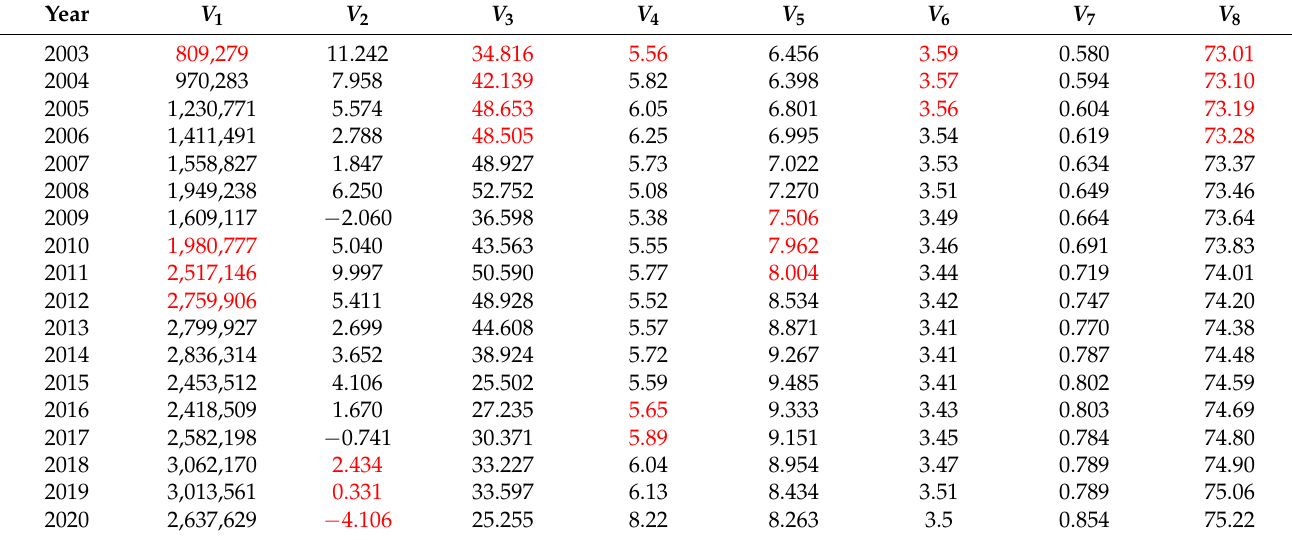
Table 1. Variables and their values: (black) real values created by the authors based on data provided on different websites, (red) missing values reconstructed by wavelet method as in Section 4.1.